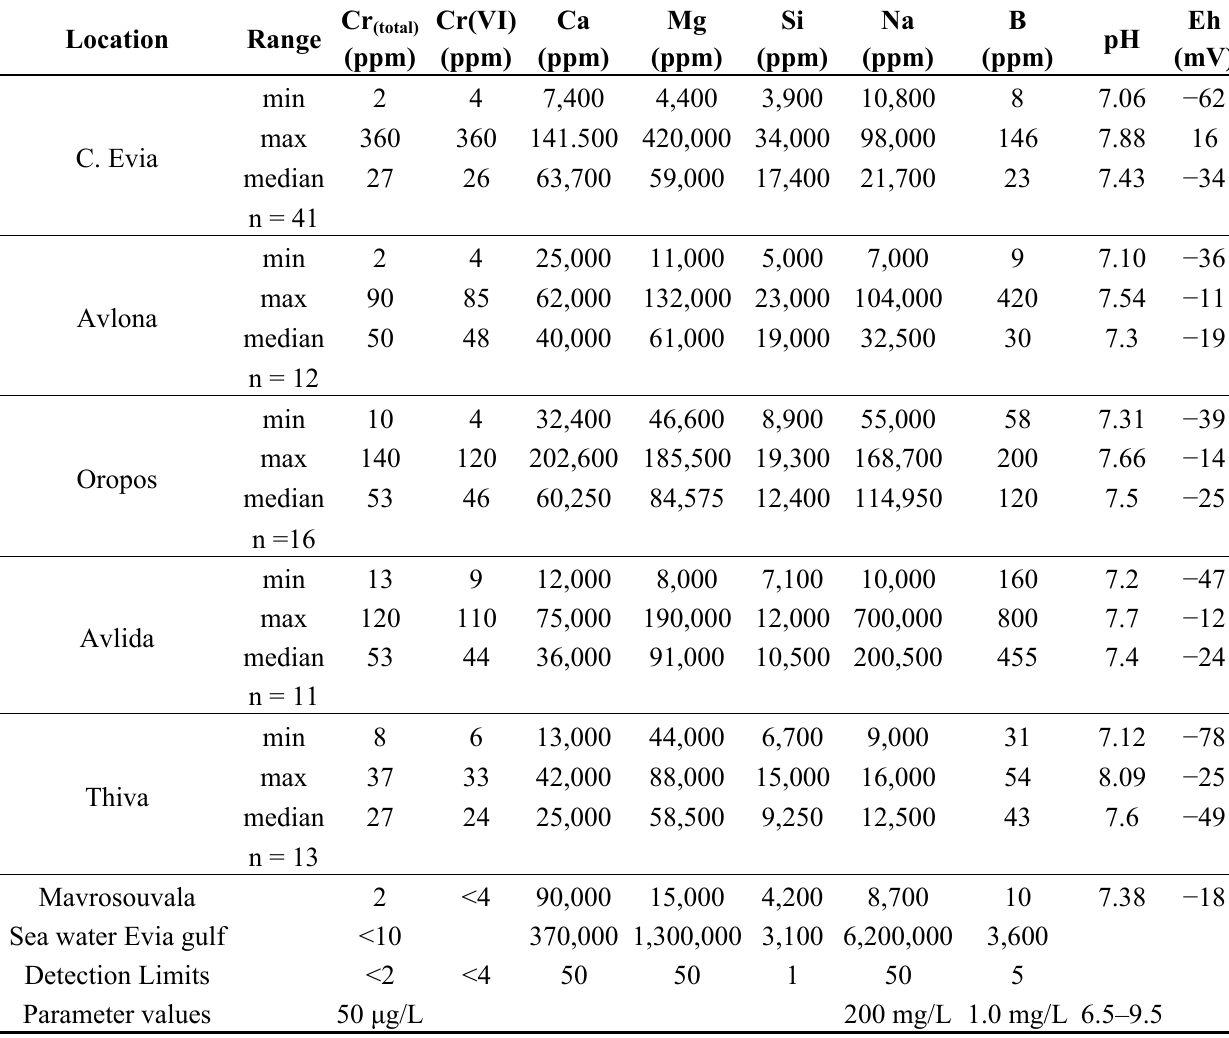
Table 5. Trace element concentrations ( μ g/L) and other parameters in groundwater from the Assopos-Thiva basins and C. Evia, and sea water (data sources in text).